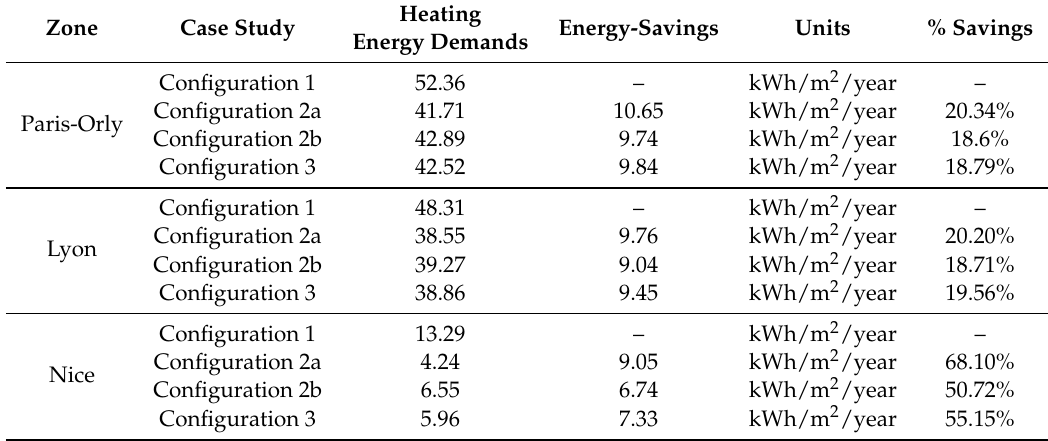
Table 9. Ratio of energy savings, based on the reduced setpoint temperature of 16–19 ◦ C, for the studied configurations (2a, 2b, and 3), compared to Configuration 1 across all three climatic conditions.